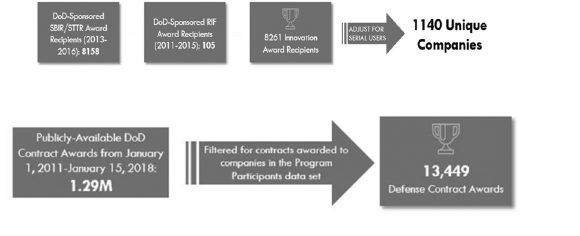
Figure 4. Distribution of